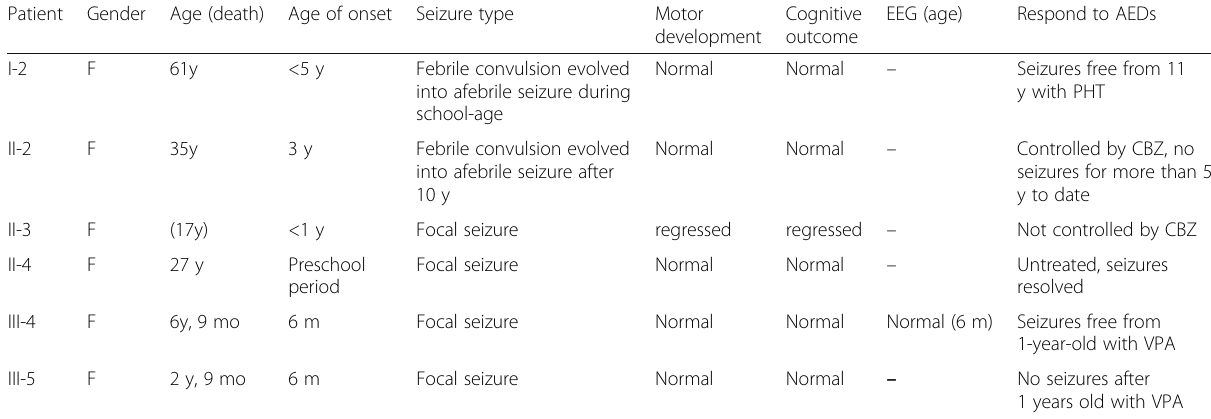
Table 1 Clinical features of affected member of SCN8A mutation in the pedigree Patient Gender Age (death) Age of onset Seizure